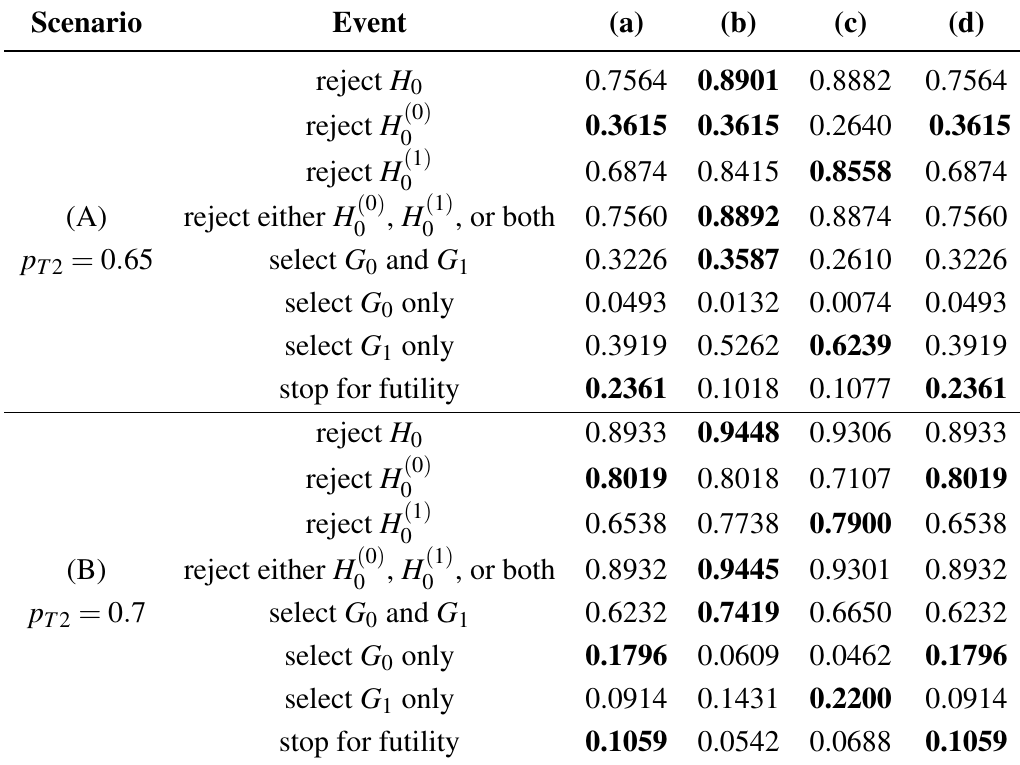
( 1 ) ; H ( 0 ) , H and either H 0 0 0